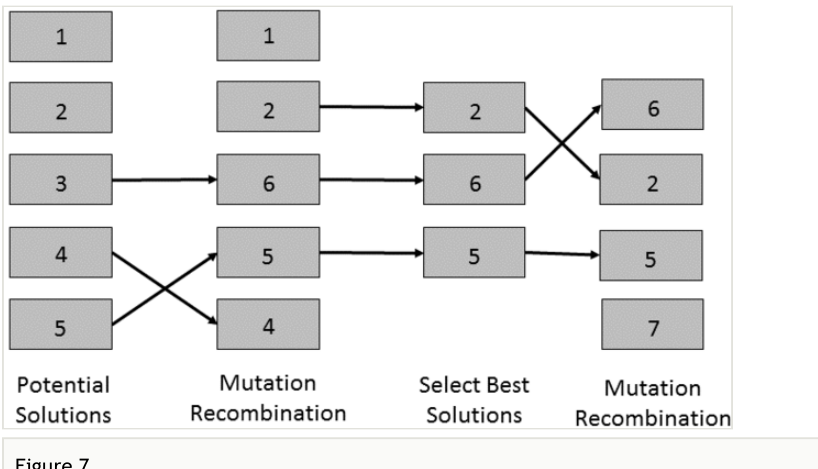
Figure 7. Genetic Algorithm Schematic : In this simpli fi ed schematic of a genetic algorithm, the fi ve potential solutions, or “chromosomes”, undergo mutation and recombination. Then the best performing solutions are selected for another iteration of mutation and recombination. This cycle is repeated until an optimal solution is